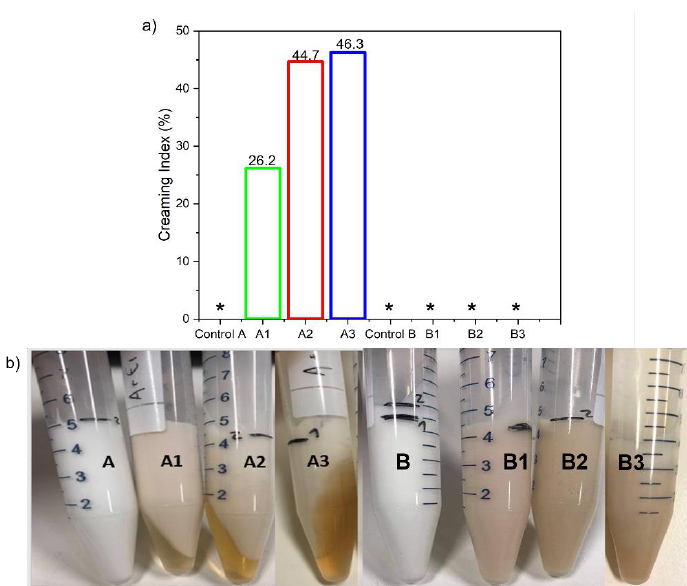
Figure 5. (a) Creaming index (%), where * means no phase separation occurred (no creaming oc- curred) and ( b ) physical appearance of cosmetic formulations: formulation A with the three incor- porated extracts (A1, A2, and A3) and formulation B with the three incorporated extracts (B1, B2, and